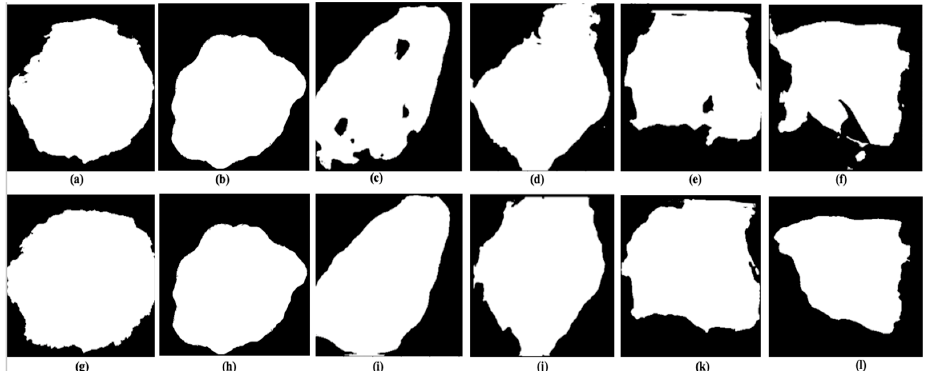
Figure 12. The robustness of the proposed model in predicting the un-curated images. The first row ( a – f ) shows the predicted masks of un-curated images from Figure 5 ( a – f ) , and the second row ( g – l ) shows the related predicted masks of curated images from Figure 5 ( g – l ).